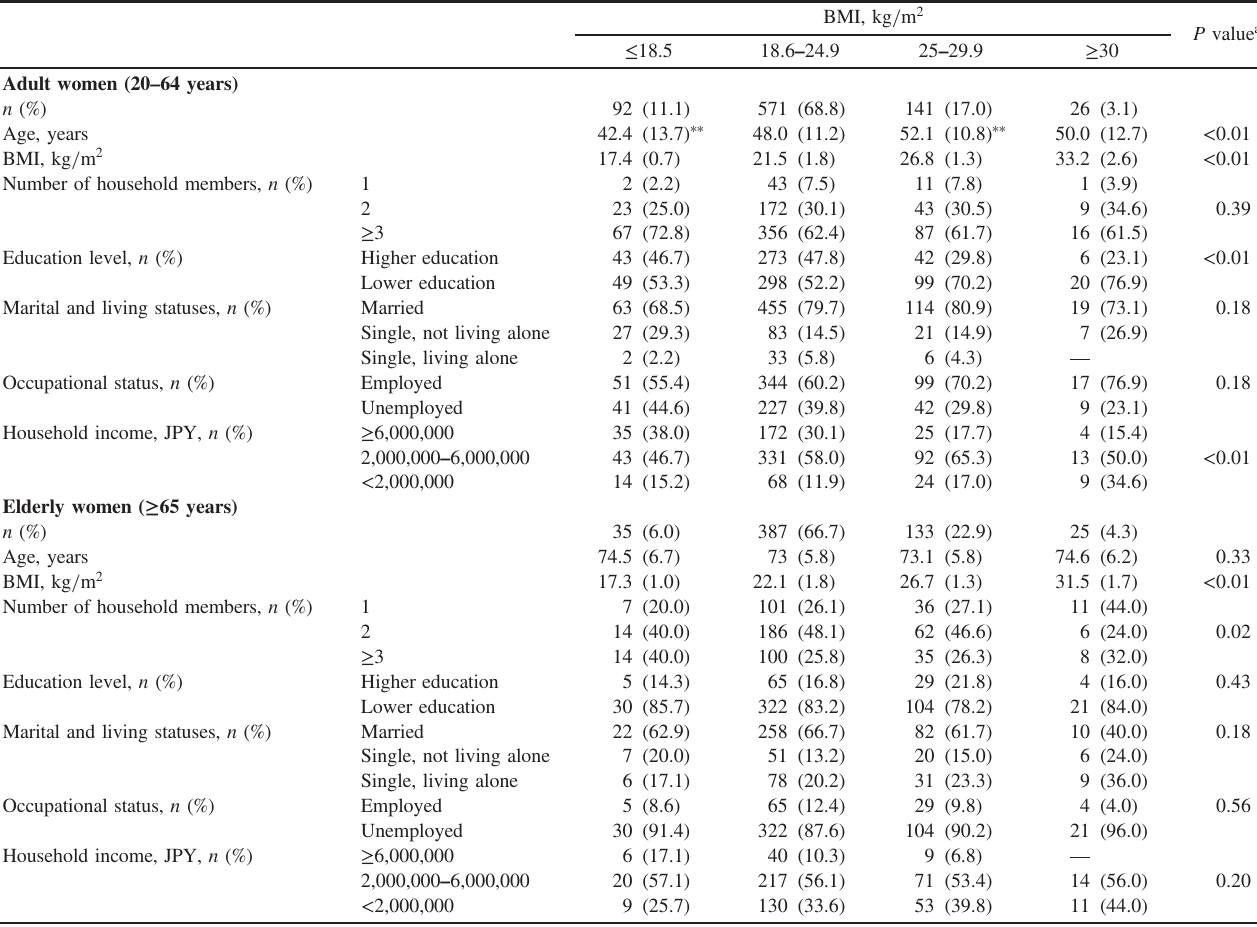
Table 2. Background characteristics according to BMI categories in women (NIPPON